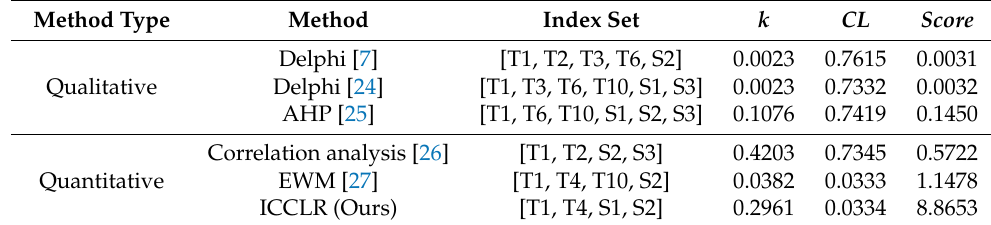
Table 3. Comparison results of different index sets.